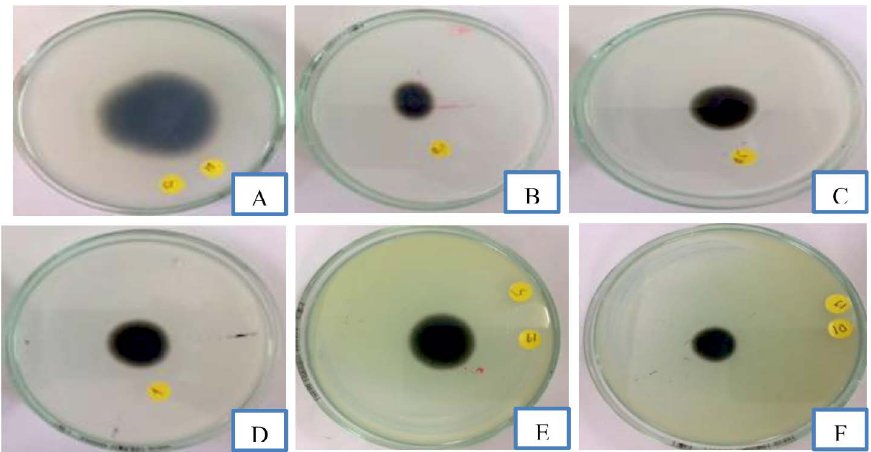
Fig. 3. Mycelia growth of Isolate 2 of P.grisea in response to control (A), 0.1 mg/mL (B), 0.5 mg/mL (C), 1 mg/mL (D), 5 mg/mL (E) and 10 mg/mL (F), respectively of Commela communis L. extract on PDA